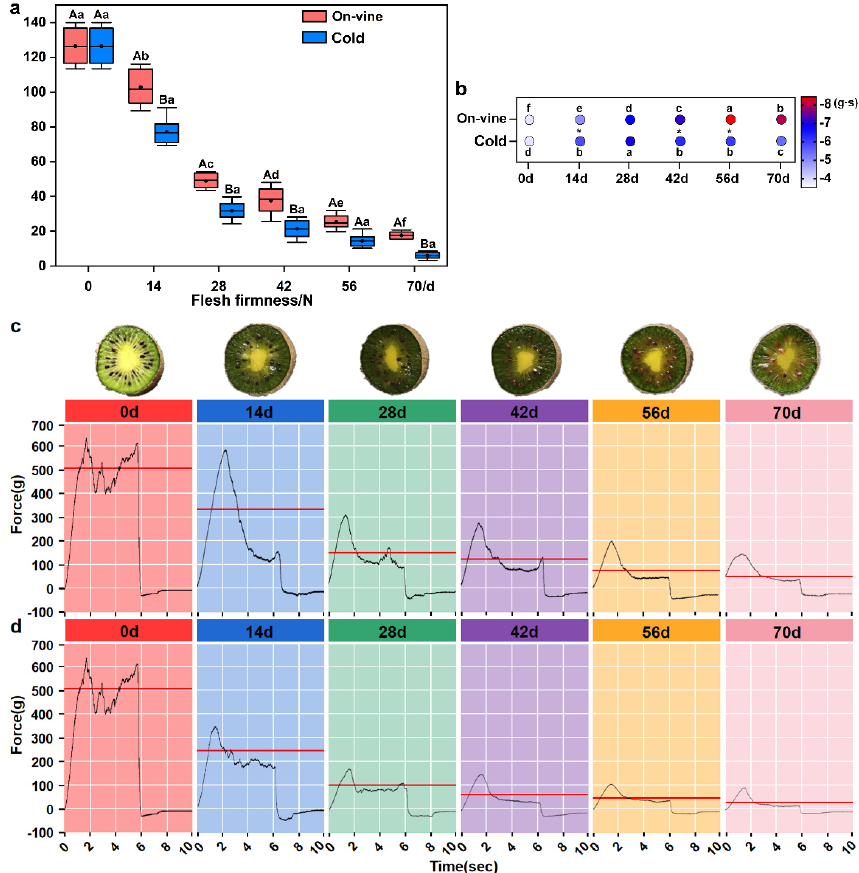
Figure 4. Changes of flesh firmness and cohesiveness. ( a ) Flesh firmness. ( b ) Flesh cohesiveness. ( c ) The TPA characteristic curve of the on-vine group. ( d ) The TPA characteristic curve of the cold group. Data are expressed as mean ± standard deviation of three biological repetitions. Error bars represent standard deviations of means. Different capital letters or ‘*’ represent the difference between the two softening methods at the same harvest time. Different lowercase letters are significantly different at p < 0.05. Data were analyzed with one-way analysis of variance (ANOVA) and Duncan’s multiple range tests. The red line in ( c , d ) represents the calculated flesh firmness, and this value was the average of all biological and technical repetitions of different methods in each collection period. Only one characteristic curve was selected to represent the test result, and other characteristic curves had only slight errors. Foods 2022 , 11 , x FOR PEER REVIEW